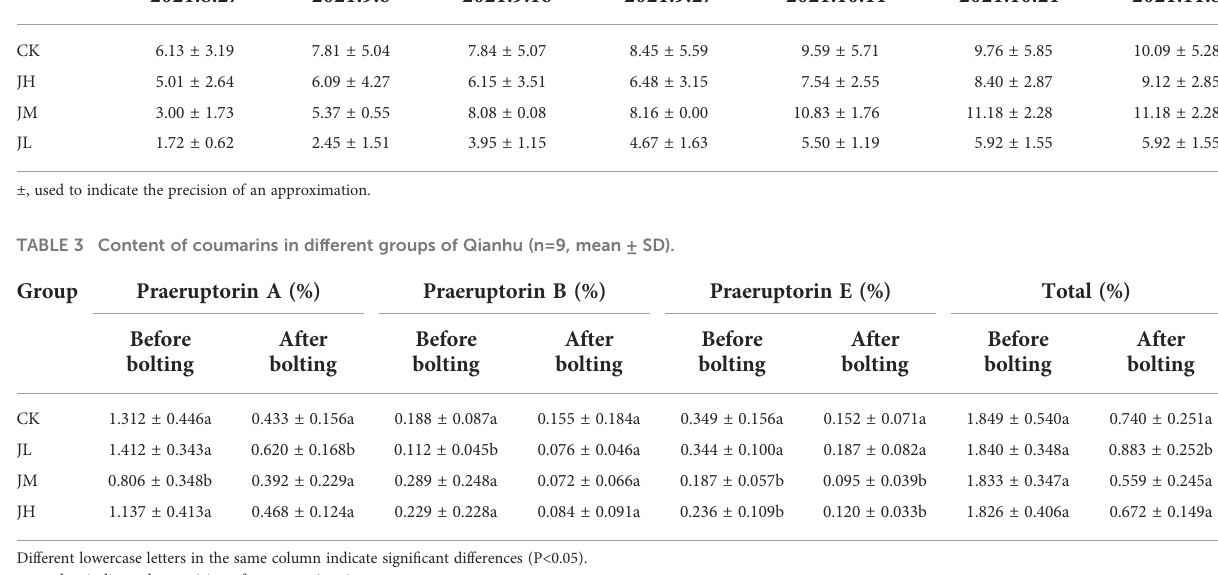
Different lowercase letters in the same column indicate signi fi cant differences (P<0.05). ±, used to indicate the precision of an approximation.